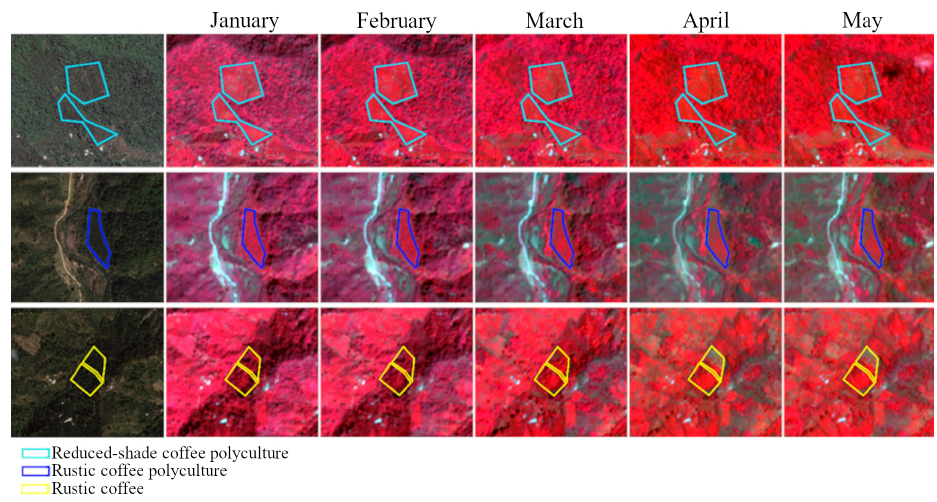
Figure 6. Spectral profile variations for coffee agroforestry systems in color infrared (B8, B4, B3) from Sentinel-2.